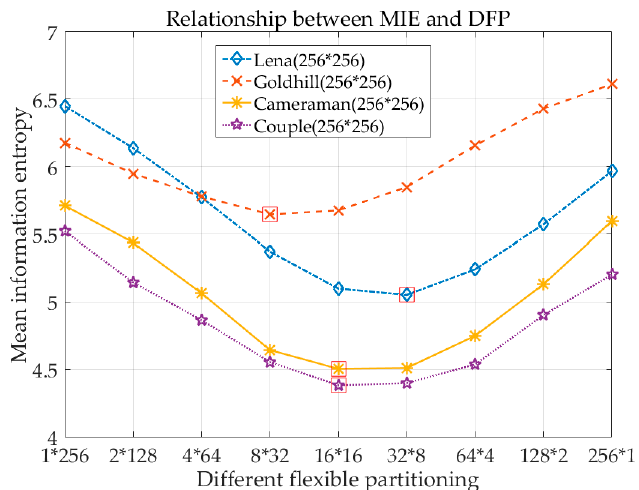
Figure 1. E ff ect of di ff erent partitioning methods on mean information entropy (MIE) of images (the Figure 1. Effect of different partitioning methods on mean information entropy (MIE) of images (the abscissa represents flexible partitioning with shape n = l × h = 2 i − 1 × 2 9 − i = abscissa represents flexible partitioning with shape -1 9 2 2 256 i − = × = ×